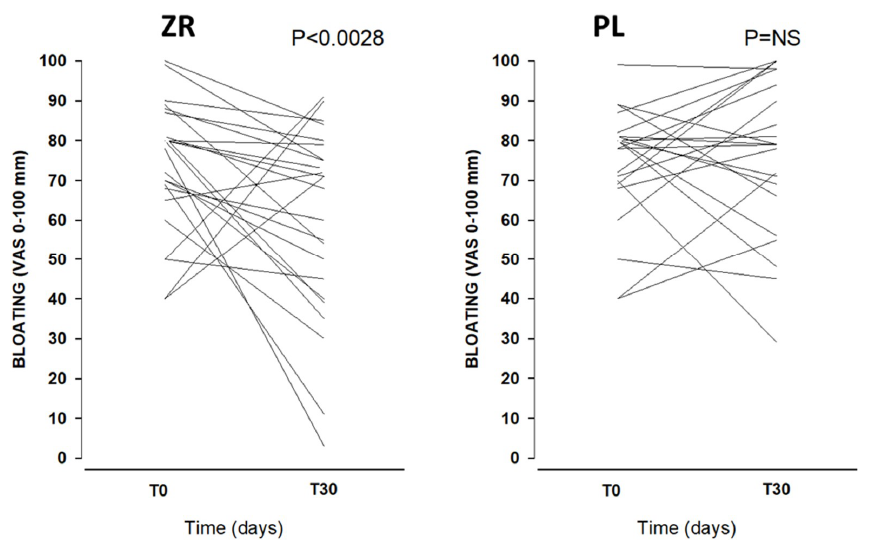
Figure 3. Representation of bloating (visual analogue scale (VAS) 0–100 mm) in 23 patients at baseline (T0) and after 30 days (T30) of treatment (ZR) and placebo (PL) by spaghetti graft.